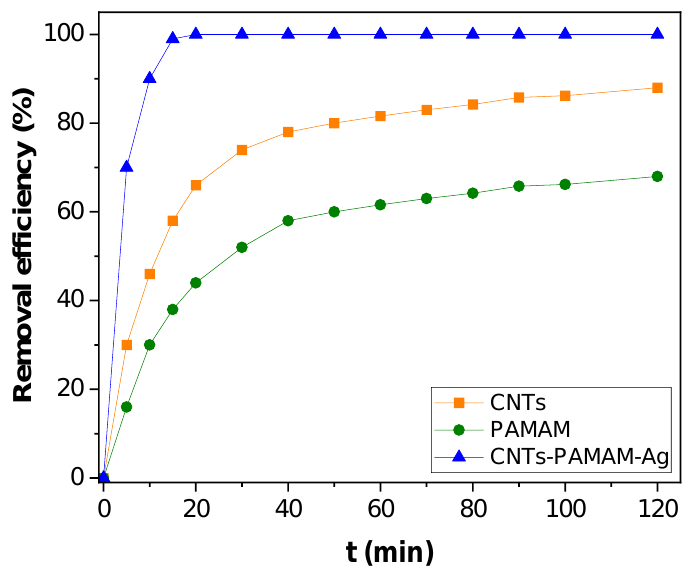
Figure 5. Kinetics of Pb(II) adsorption over oxidized CNTs, PAMAM and CNTs – PAMAM – Ag.